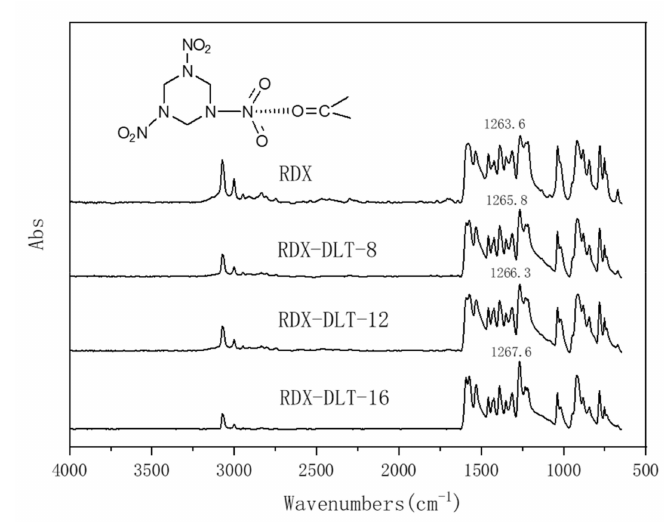
Figure 4. Micro-infrared spectra of hexogen (RDX) and RDX coated with DLT-8, DLT-12 and DLT-16, and the interaction mechanism between the bonding agents and RDX (inserted